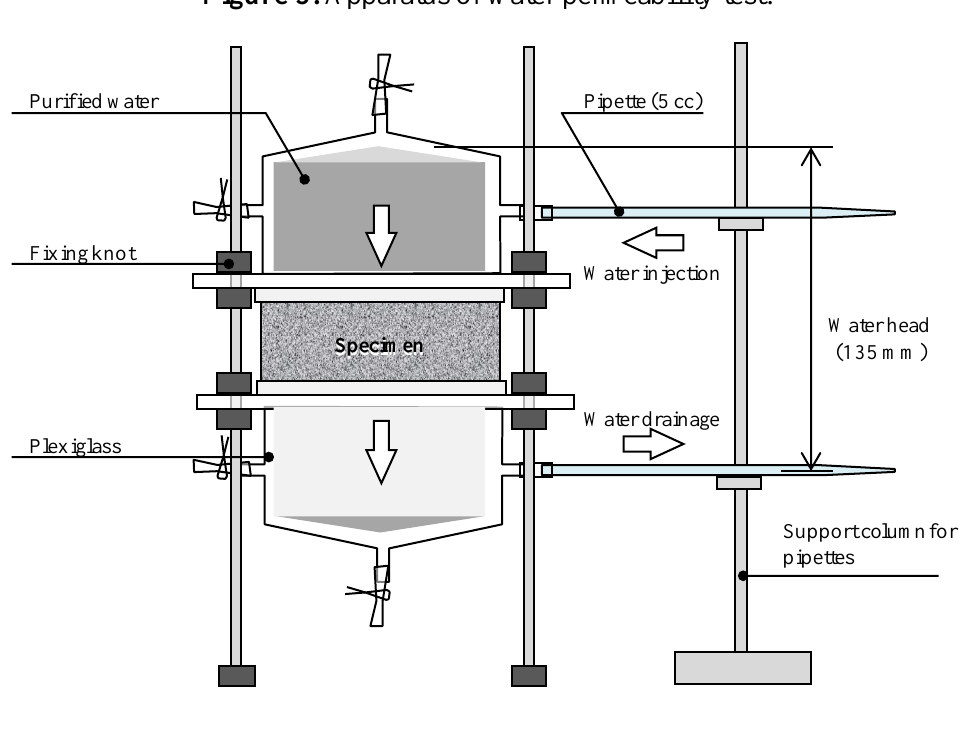
Figure 5. Apparatus of water permeability